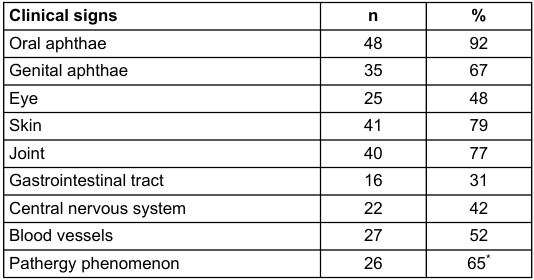
Table 3: Organ involvement (total n = 52).